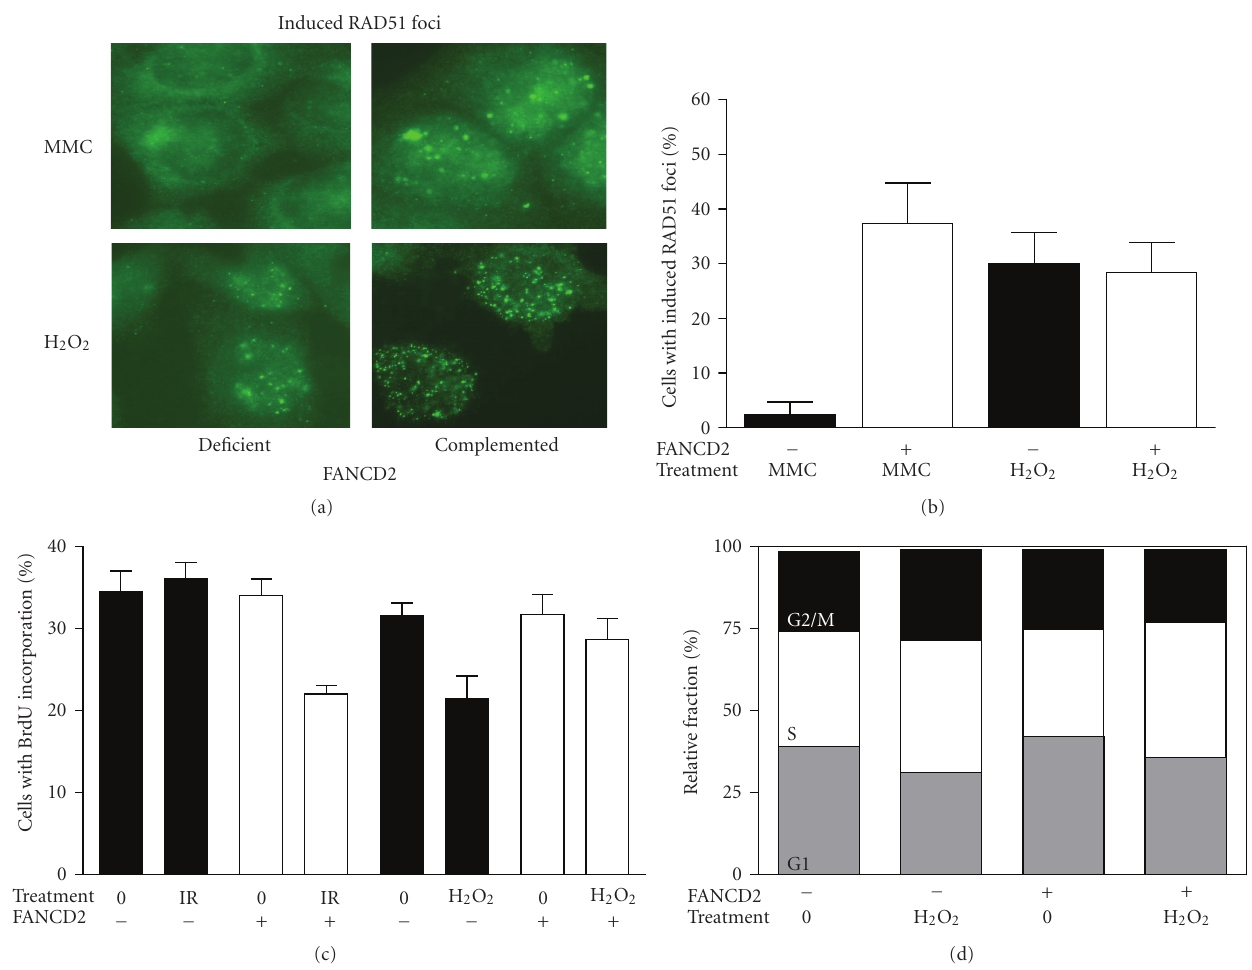
Figure 3: Normal DNA damage responses in FANCD2-deficient cells treated with hydrogen peroxide (H 2 O 2 ). (a) Illustration of RAD51 foci formation in PD20 and PD20-wtD2 cells 5 hours after exposure to MMC (0.25 μ g/mL for 1 hour) or H 2 O 2 (25 μ M for 2 hours). (b) Induction of RAD51 foci formation above background levels by MMC or H 2 O 2 . Because equal drug concentrations were used, rather than isoe ff ective concentrations with regard to cell survival, the extent of foci induction between FANCD-deficient and -complemented cells is not directly comparable. Data represent means with upper standard error based on three independent repeats. (c) DNA synthesis measured by BrdU pulse labeling in cells treated with ionizing radiation (IR, 8Gy) or H 2 O 2 (25 μ M). Data represent means with upper standard error based on two independent experiments. (d) Cell cycle distribution of propidium-iodide cell populations by flow cytometry. A representative experiment is shown. Percentages of cells in the G1, S, and G2 (and M) phases of the cell cycle are